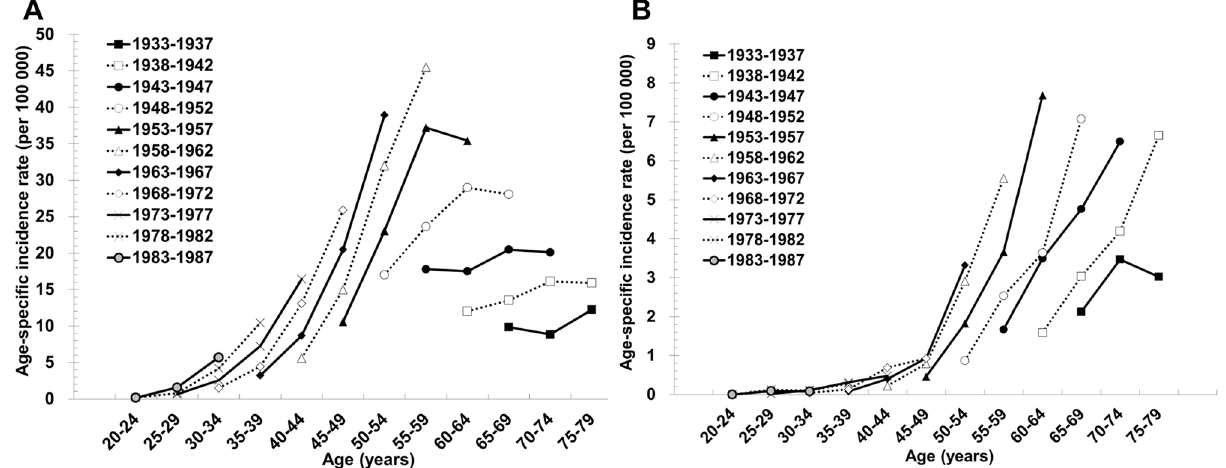
Figure 3. Birth cohort effects on incidence trends of endometrial cancer over time. Age-specific incidence of ( A ) endometrioid carcinoma and ( B ) nonendometrioid carcinoma, grouped by birth cohort.